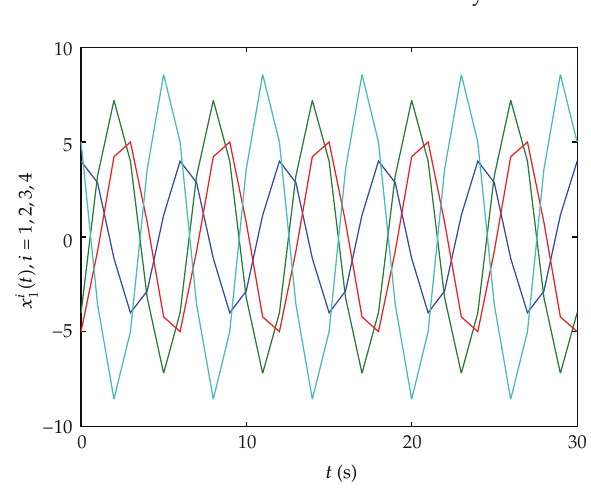
Figure 1: The time histories of x i